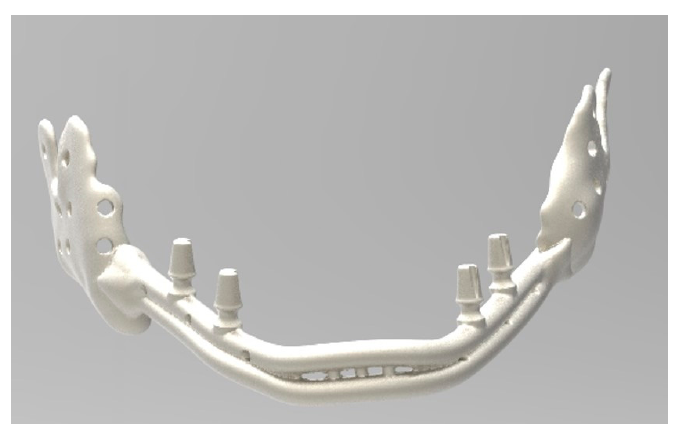
Figure 6. Frontal view.